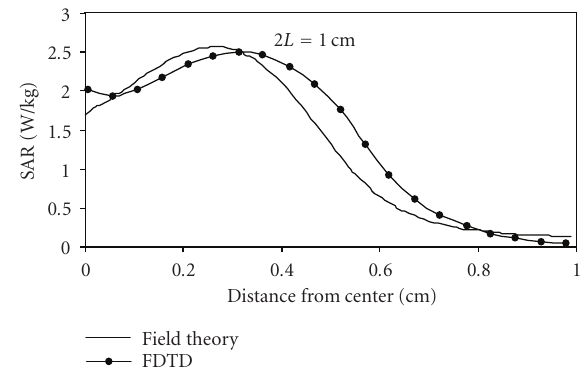
Figure 3: SAR at surface of the tissue for the 1cm total length an-